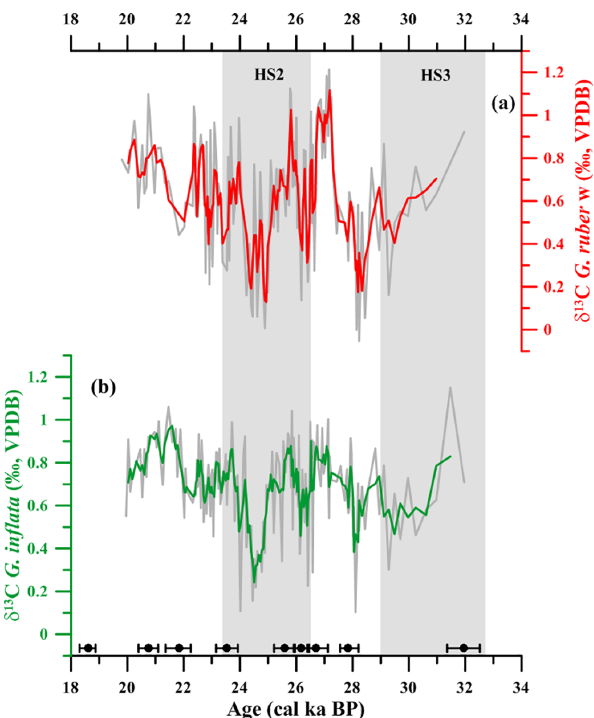
Figure 4. Stable carbon isotopic ( δ 13 C) records from sediment core GeoB6212-1. (a) Globigerinoides ruber white ( G. ruber w) δ 13 C and (b) Globorotalia inflata ( G. inflata ) δ 13 C. Red and green lines represent three-point running averages for G. ruber w and G. in- flata , respectively. Black symbols at the bottom of the panel depict calibrated ages. Grey vertical bars show abrupt millennial-scale cli- mate change events Heinrich Stadial 3 (HS3) and Heinrich Stadial 2 (HS2) (Goni and Harrison, 2010; Sarnthein et al.,